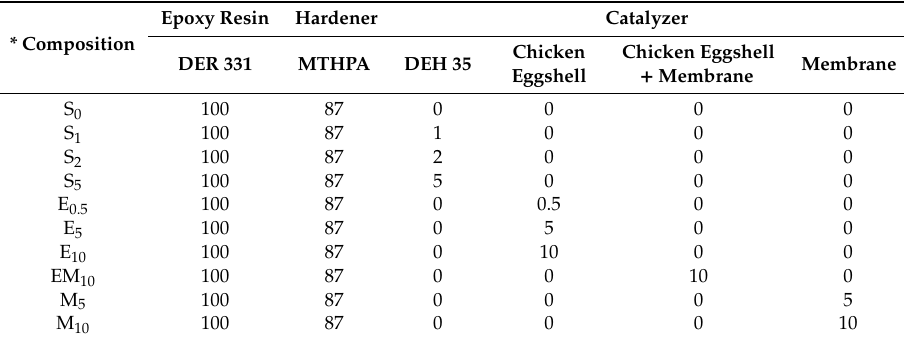
Table 1. Epoxy compounds and their component contents.